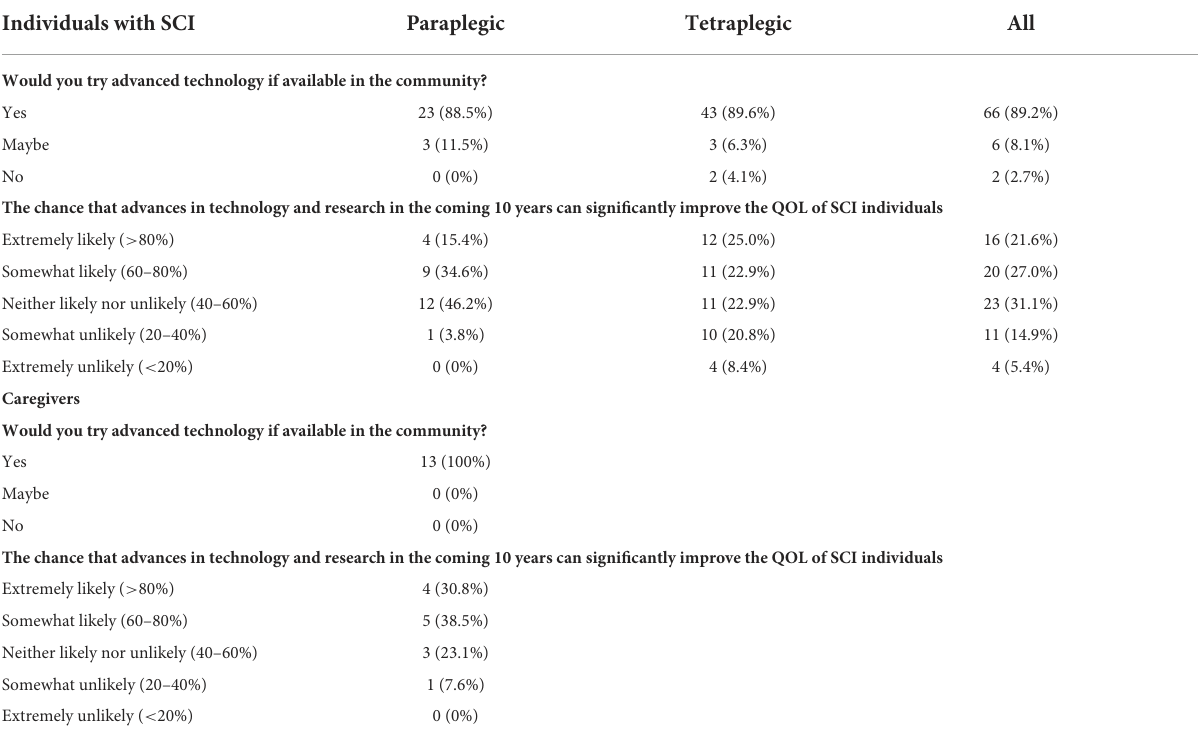
TABLE 7 Views on the advancement in technology and